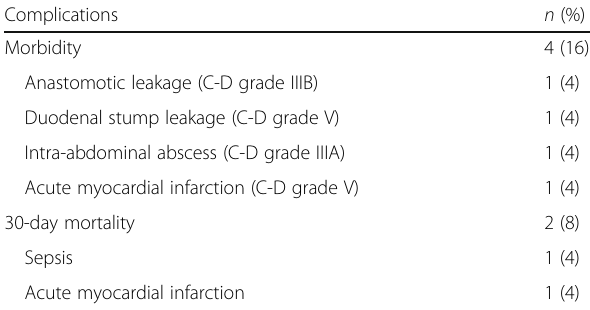
Table 4 Postoperative